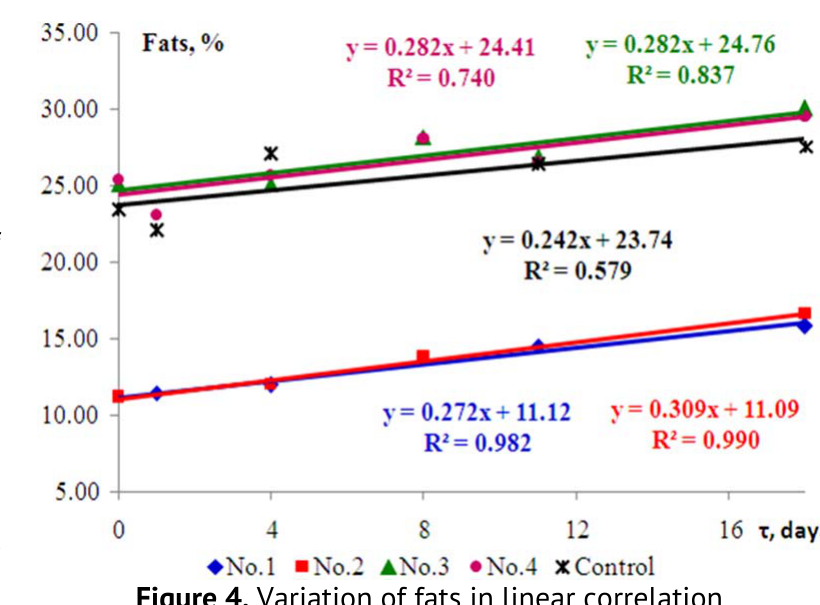
Figure 4. Variation of fats in linear